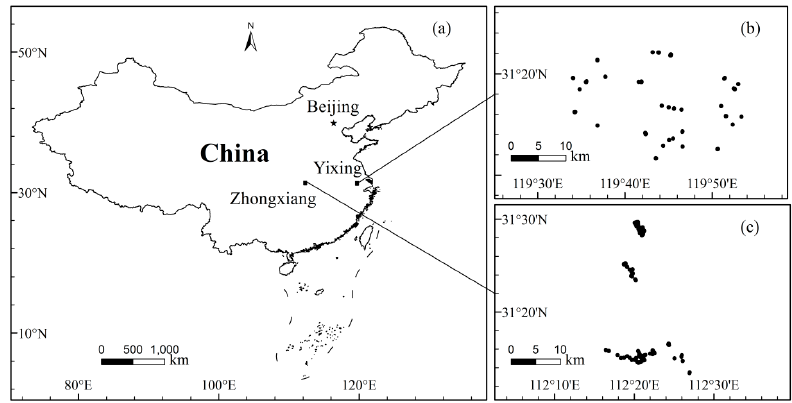
Figure 1. Study areas ( a ) and spatial distribution of soil samples in Yixing ( b ) and Zhongxiang ( c ).